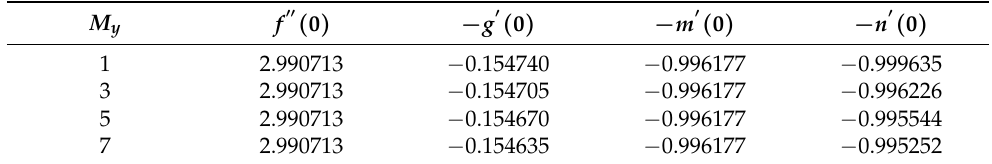
Table 7. Estimated values for f (cid:48)(cid:48) ( 0 ) , − g (cid:48) ( 0 ) , − m (cid:48) ( 0 ) , and − n (cid:48) ( 0 ) with fixed S z = − 0.1, M x = 0.5, R m = 0.01, S = 1, and different values of M y .